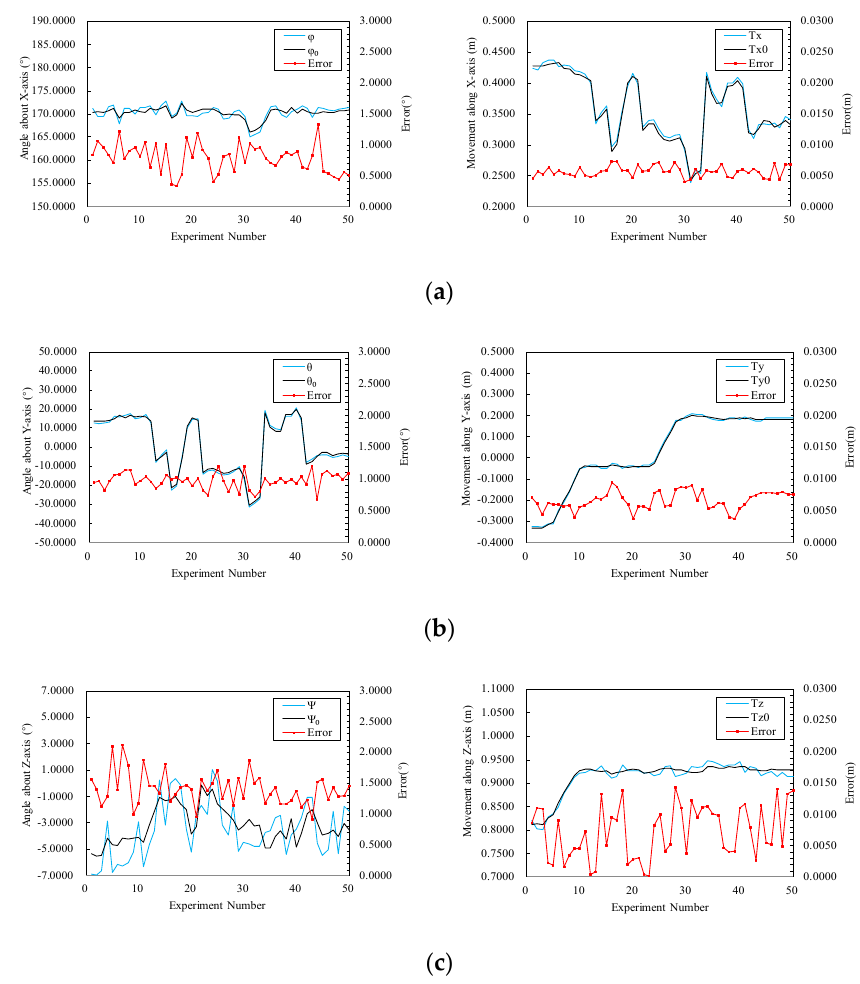
Figure 8. Measurement results and errors of 6-DOF (measurement distance is 3 m): ( a ) measurement results and errors in the x -axis direction; ( b ) measurement results and errors in the y -axis direction; ( c ) measurement results and errors in the z -axis direction.